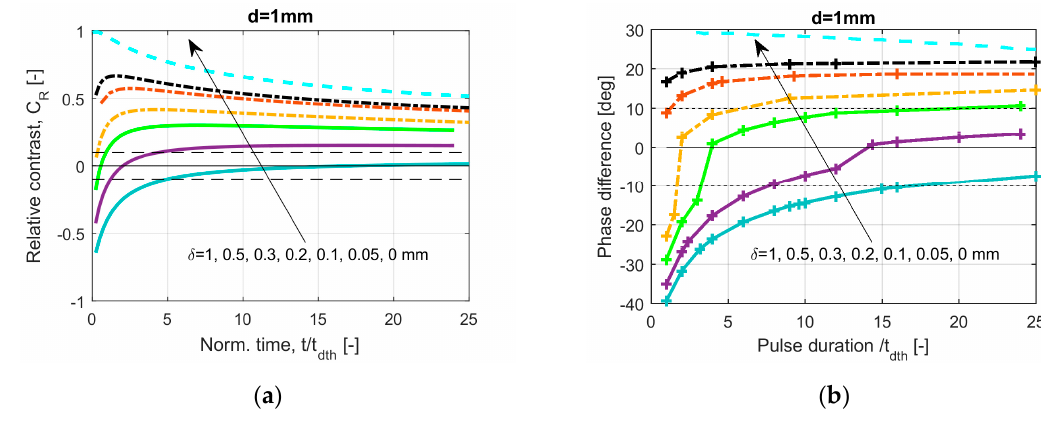
Figure 23. Relative temperature contrast ( a ) and phase difference ( b ) for a crack with d = 1 mm calculated for different penetration depth values.